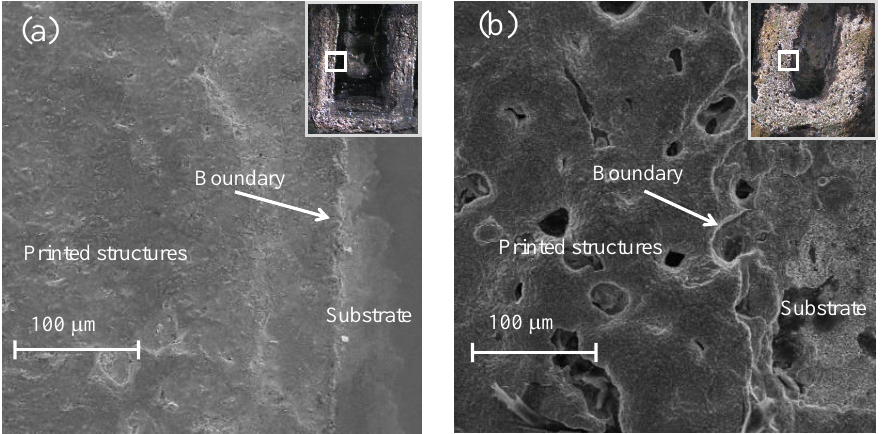
Figure 9. SEM images of the letter “U” printed under ( a ) pulsed and ( b ) constant potential.